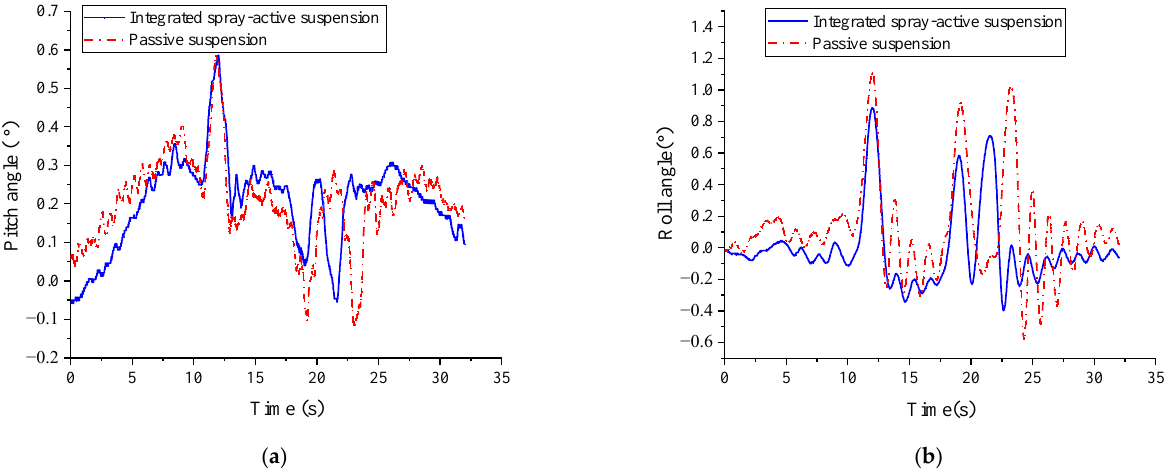
Figure 12. Triangle obstacle.